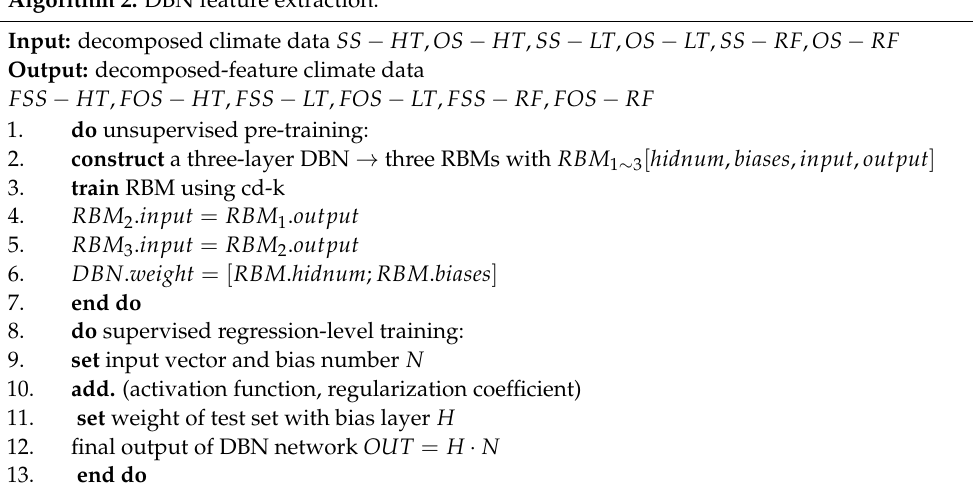
Algorithm 2. DBN feature